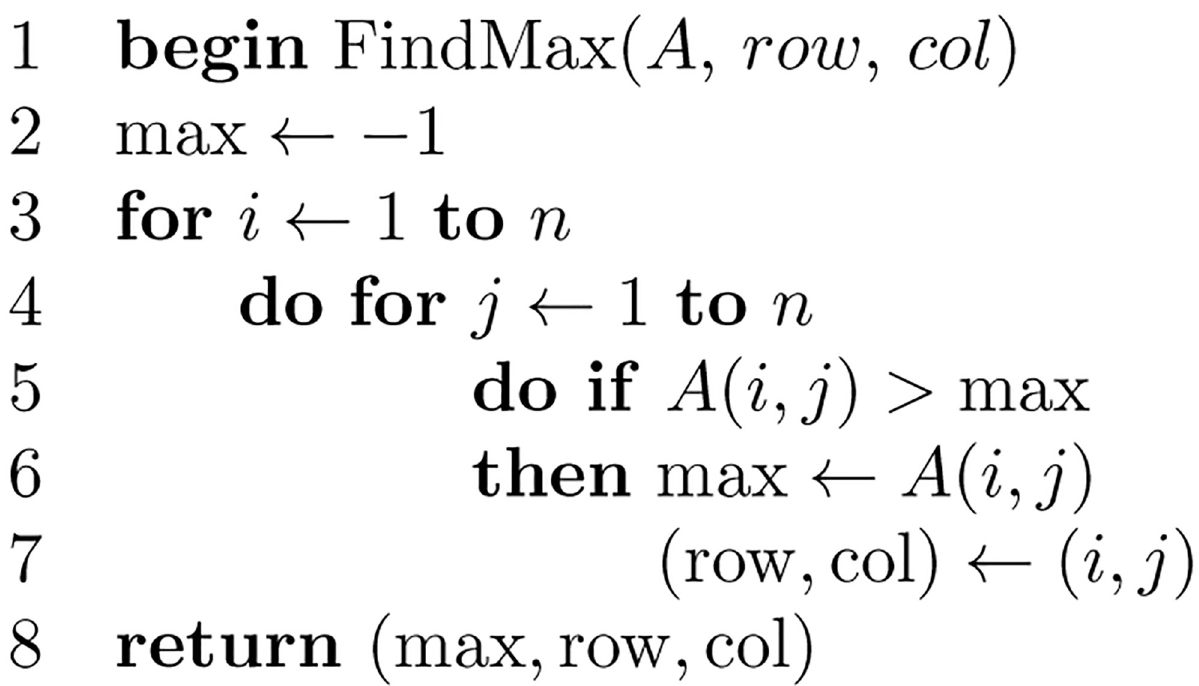
Fig 19. Algorithm to find the maximum of a matrix A .